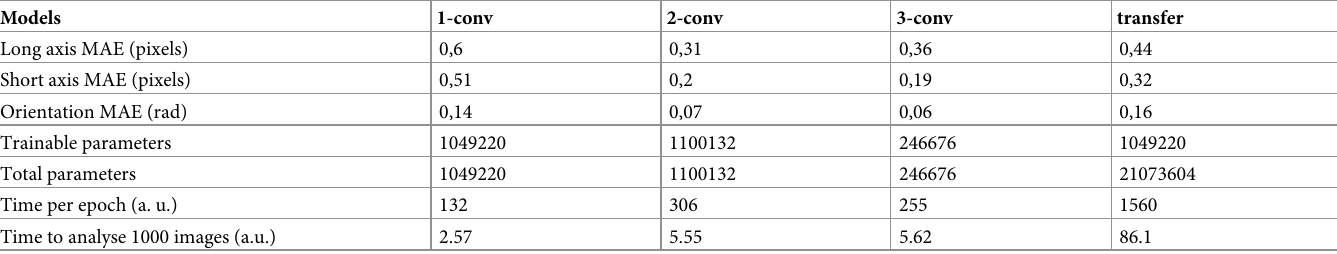
Table 1. Comparison of all four final models.